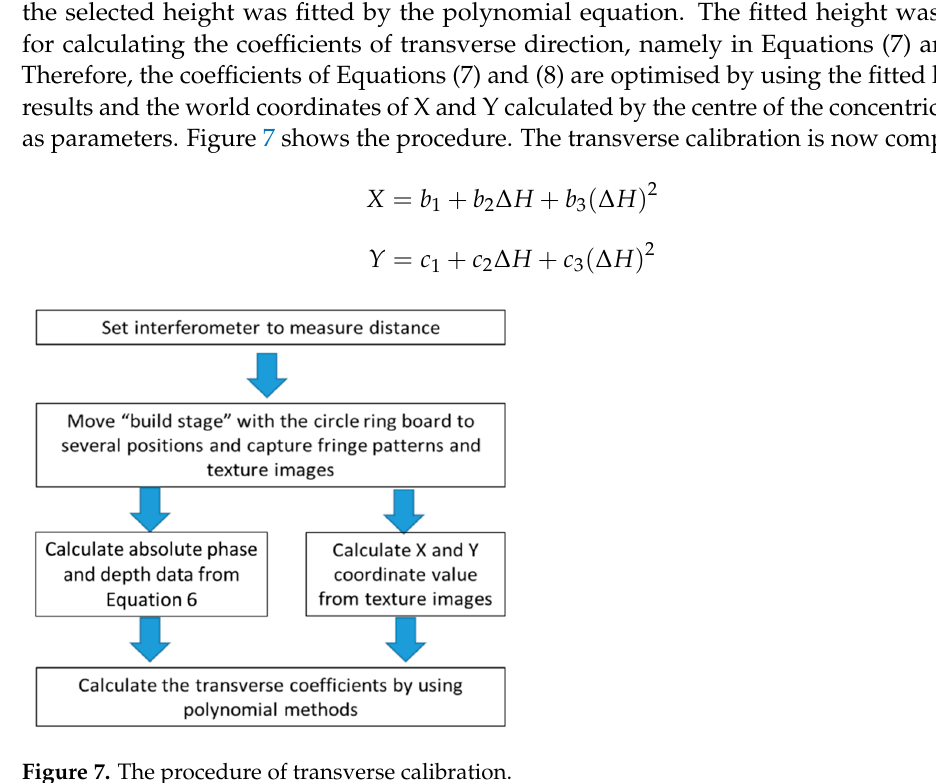
( b ) Figure 8. Measurement results of a flat plate: ( a ) 3D shape measurement results with impact of black circle ring (typical rings circled); and ( b ) 3D shape measurement results with the proposed method. In order to verify the measurement accuracy of the system, the verification method was divided into two steps: horizontal direction and vertical direction. For the horizontal direction verification, texture images of four positions were collected within the calibra- tion range, and the centres of the rings were extracted and the distance between the cen- tres calculated as shown in Figure 9. The calculated results were compared with the pa- rameters reported in the calibration plate inspection report. The compared values are shown in Table 1. It can be clearly seen that the mean absolute error in the Y direction is higher than that in the X direction, which is because there is an angle between the optical axis of the camera and the normal line of the calibration plate when the camera is operat- ing. As a result of the angle between the optical axis of the camera and the normal line of the calibration plate, a perfect circle becomes an ellipse in the camera view. The centre of the ellipse extracted in the X direction deviated from the true centre of the circle, while the deviation between the extracted centre of the ellipse and the true centre in the Y direction was small, so the accuracy in the Y direction was higher.